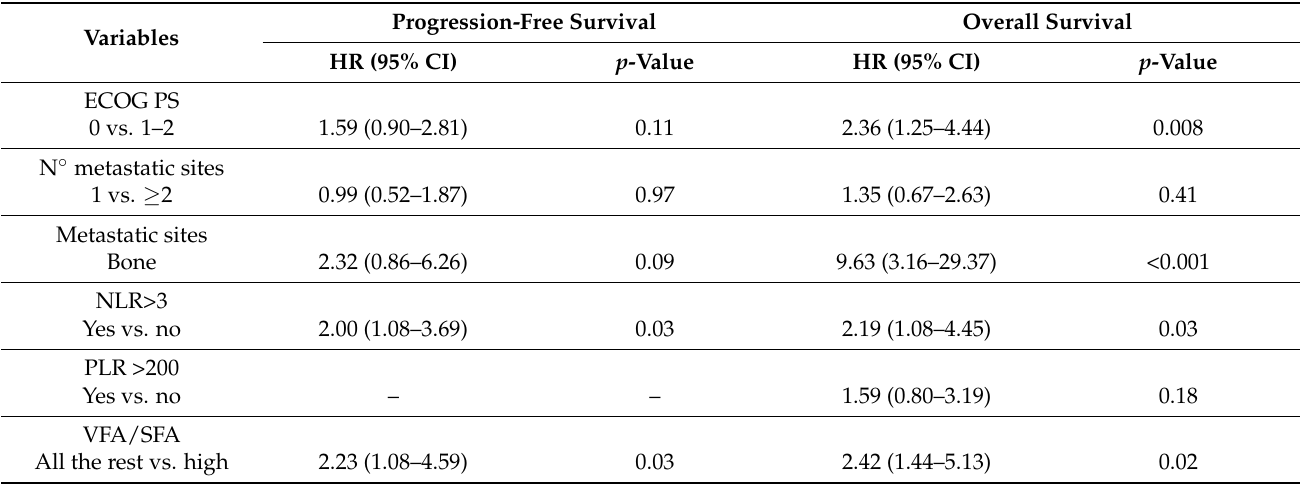
Table 3. Multivariate analysis for progression-free and overall